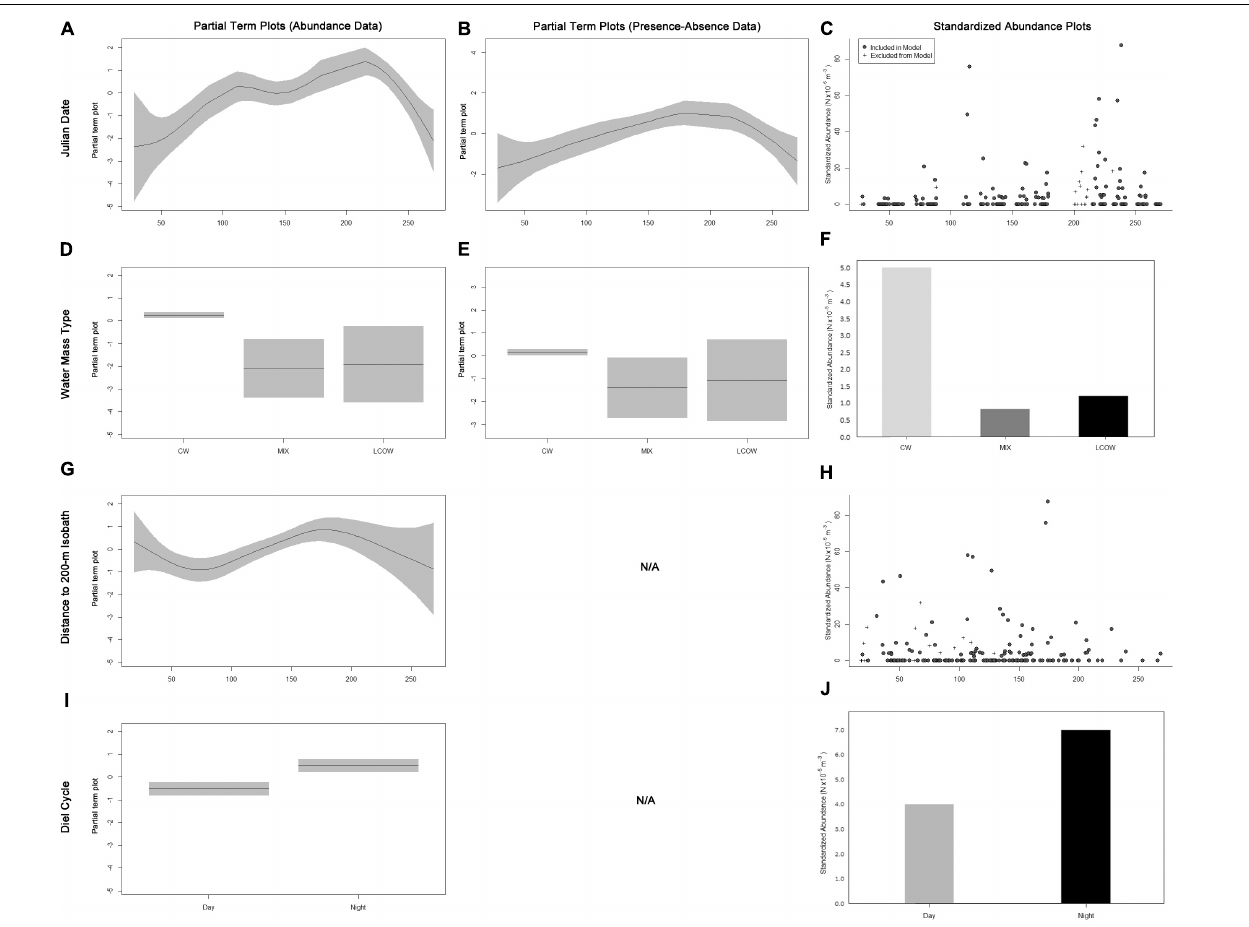
FIGURE 2 | Term plots for the best-fitting models for Scombridae data fitted to the abundance data (A,D,G,I) and presence–absence data (B,E) . Standardized abundance plots (C,F,H,J) are also presented for all important and marginally important variables. Data that had to be excluded from the model due to missing MOCNESS sensor data are indicated by